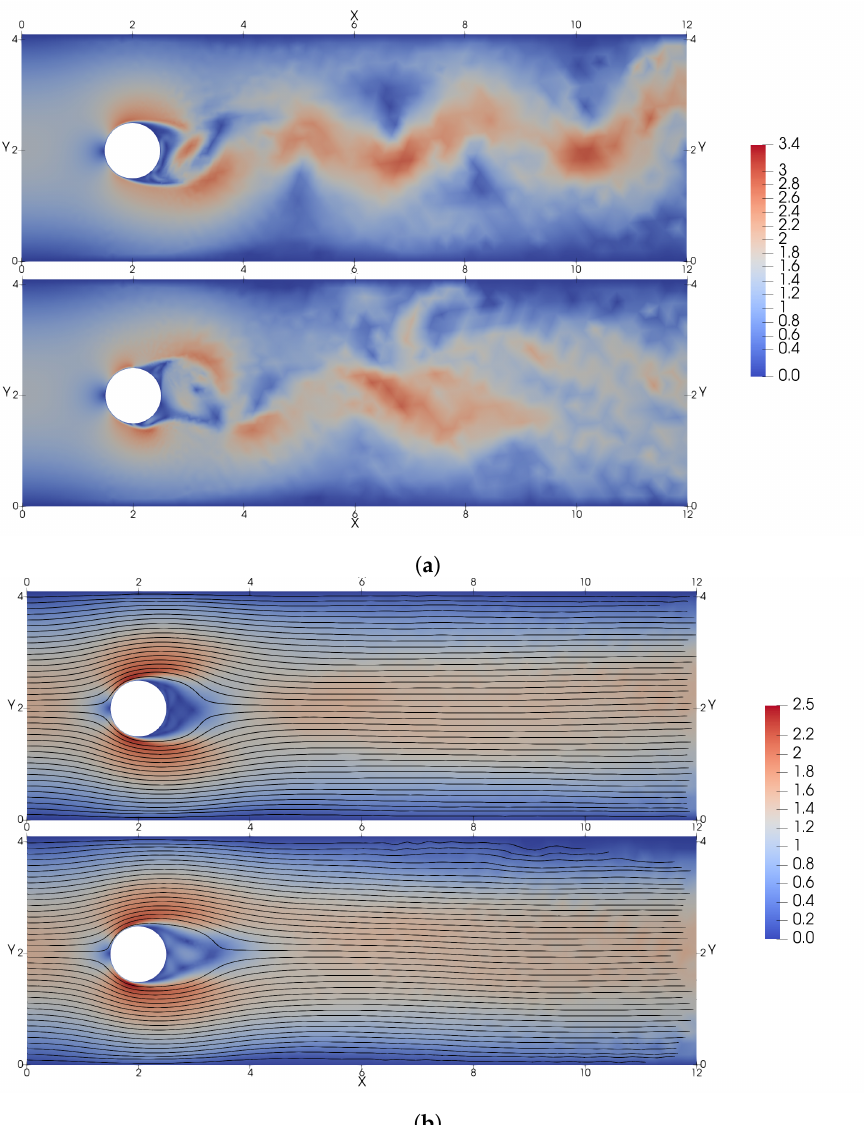
Figure 12. Instantaneous and average flow fields at Re = 1000, where for each pair of images, the baseline case without control is depicted on the top and the controlled case is depicted on the bottom. ( a ) Instantaneous magnitude of velocity fields. ( b ) Average magnitude of velocity fields, where the mean streamlines are indicated in black.